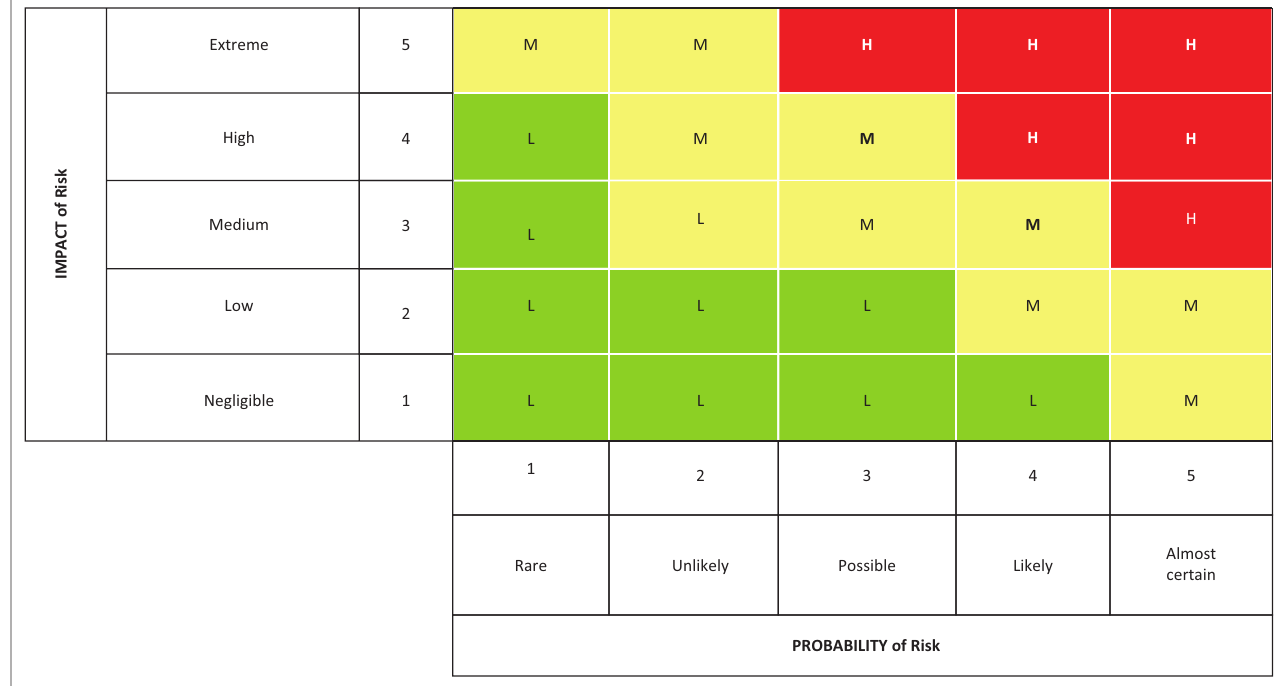
FIGURE 1: Risk rating matrix (Impact-probability